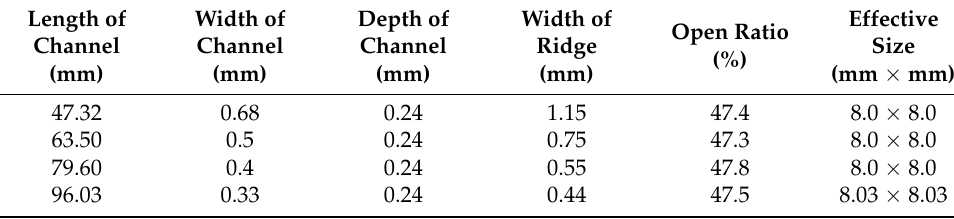
Table 3. Geometric parameters of the single-serpentine flow fields with four channel lengths. Length